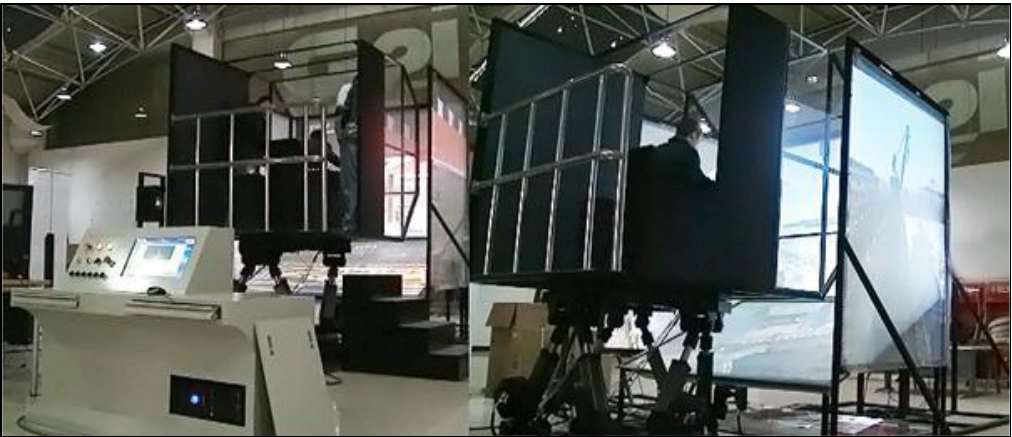
Figure 15. Physical scene of the crane simulation training system.